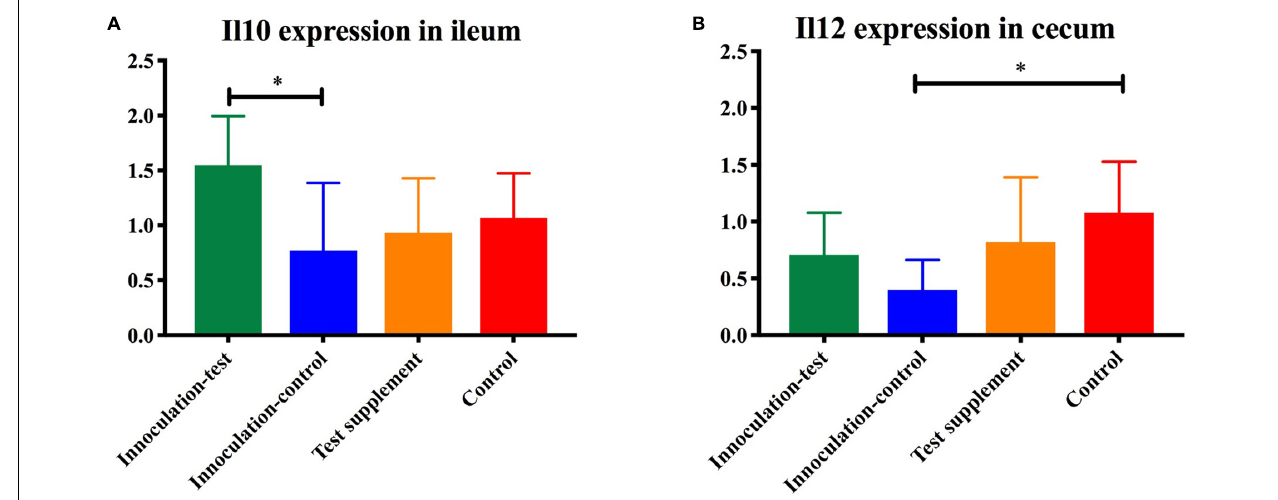
FIGURE 5 | Gene-expression of Il10 (A) and Il12 (B) measured by qPCR in the ileum of mice inoculated with microbiota from foals fed either a test supplement enriched with oligosaccharides (green) or a control diet (blue) or fed a mouse diet with (orange) or without (red) oligosaccharides. The expression of Il10 was significantly increased ( p < 0.05) in the inoculation-test group compared with the inoculation-control group and the expression of Il12 was significantly decreased in the control-inoculation group compared to the control, indicated by ∗ .